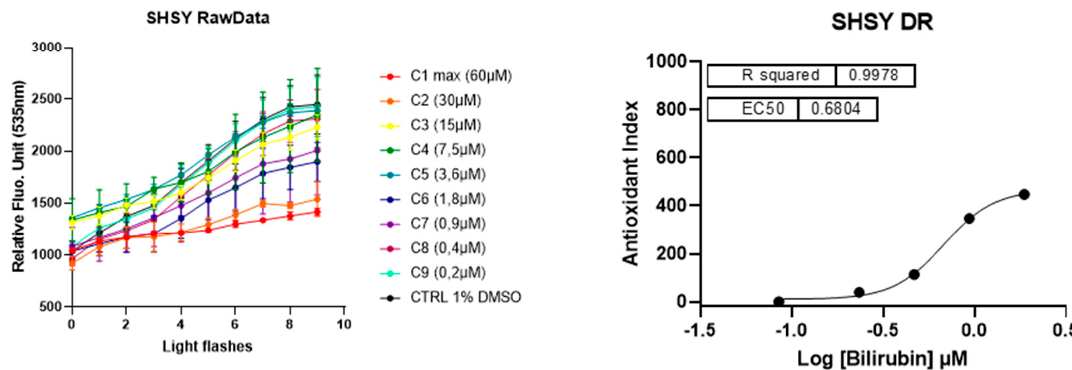
Figure 4. The antioxidant and cytotoxic e ff ect of UCB . Each cell line was incubated for 24 h with indicated UCB concentrations and then treated with the fluorescent biosensor for 1 h. Left panel reports the kinetic profiles recorded for each cell line. Relative Fluorescence Units (RFU) were measured at exc / em 501 / 535 nm according to a recurrent 480 nm LED flash application (20 iterations). Antioxidant e ff ect is measured as a delay (right shift) in fluorescence intensity increase in comparison to negative control profile. Fluorescence intensities higher than negative control at t = 0 (before light application) indicate prooxidant / cytotoxic e ff ects (as describes in [25]). Error bars represent SD values from triplicates. Right panel reports dose–response curves obtained after integration of normalized kinetic data. R 2 s represent determination coe ffi cients obtained by fitting data with a sigmoid regression analysis. Unexpected concentrations C4 (HepG2 cells) and C5 (H5V cells) were removed from the regression analysis. Each series of data corresponds to an experiment representative of at least three experiments.